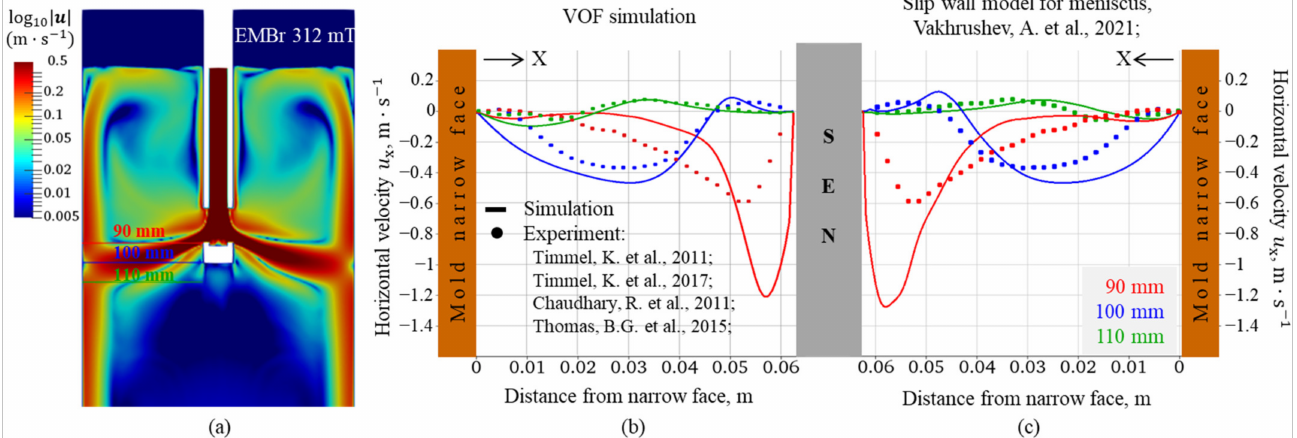
Figure 4. Verification of the simulation results with EMBr (Case 3A): ( a ) time-averaged melt velocity (midplane); horizontal velocity ( b ) in this study (experimental data from [20–23]) and ( c ) in the previous publication data from